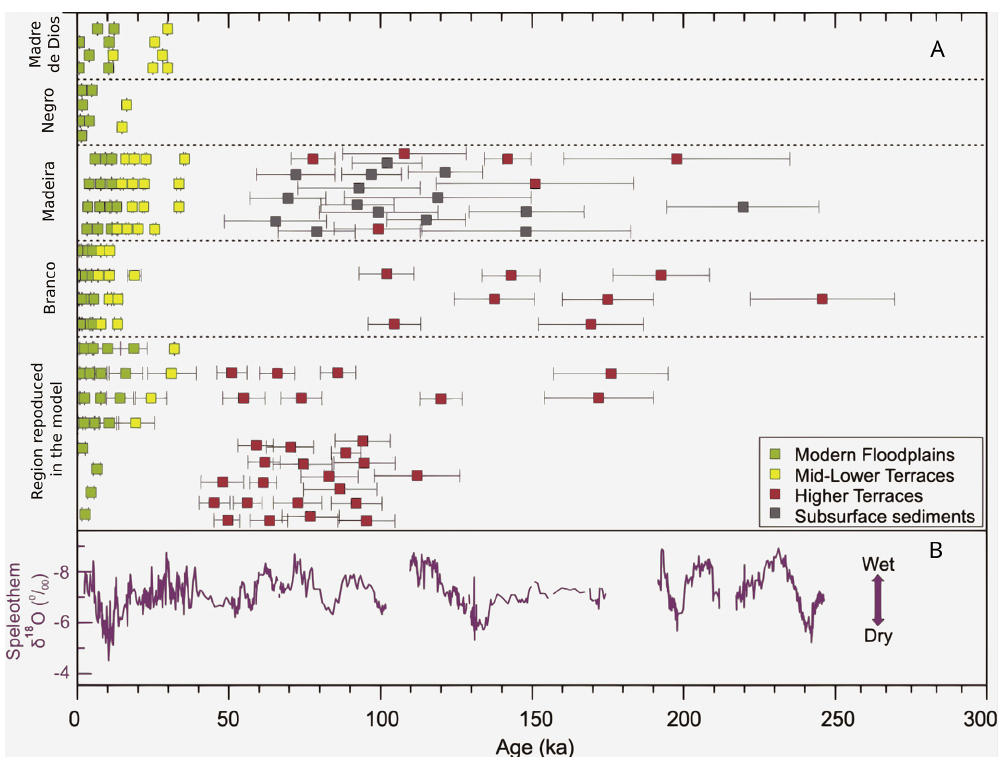
Figure 2. Chronology of sediment deposition representing the formation of terraces in Amazonian lowlands compared with Quaternary climate records from Pupim et al. (2019). (a) OSL and 14 C ages from late Quaternary deposits and (b) speleothem 18 O